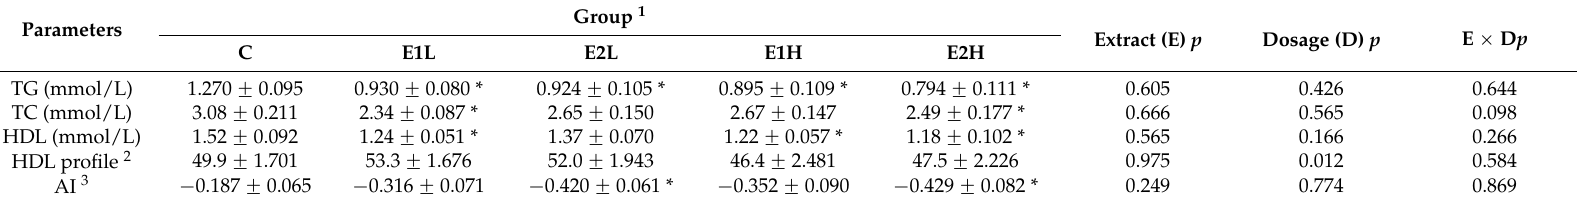
Table 4. Plasma lipid profile in